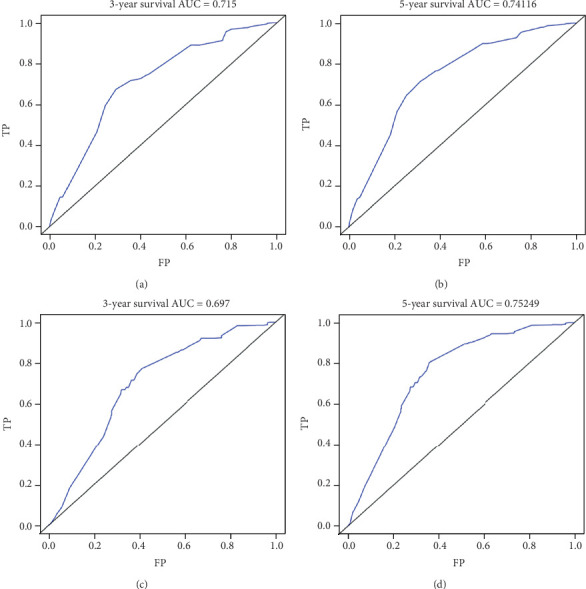
Receiver operating characteristic (ROC) curves and measurements of the area under the curve (AUC) as a means of evaluating model accuracy. (a) 3-year AUC in standard mode. (b) 5-year AUC in standard mode. (c) 3-year AUC in verification mode. (d) 5-year AUC in verification mode.